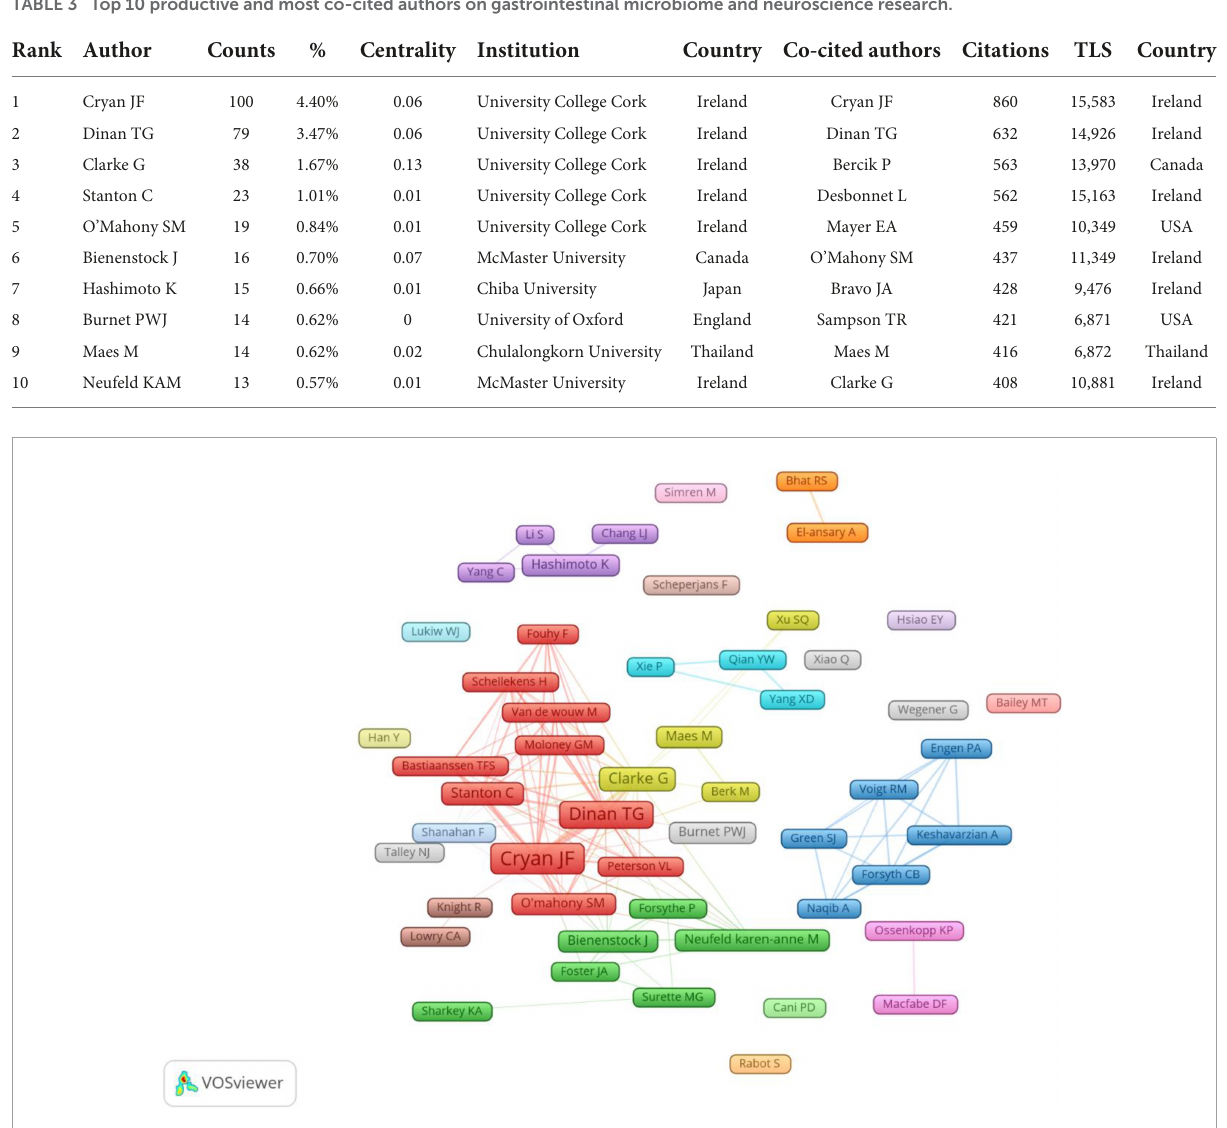
FIGURE4 The co-occurrence map of authors on gastrointestinal microbiome and neuroscience research (T ≥